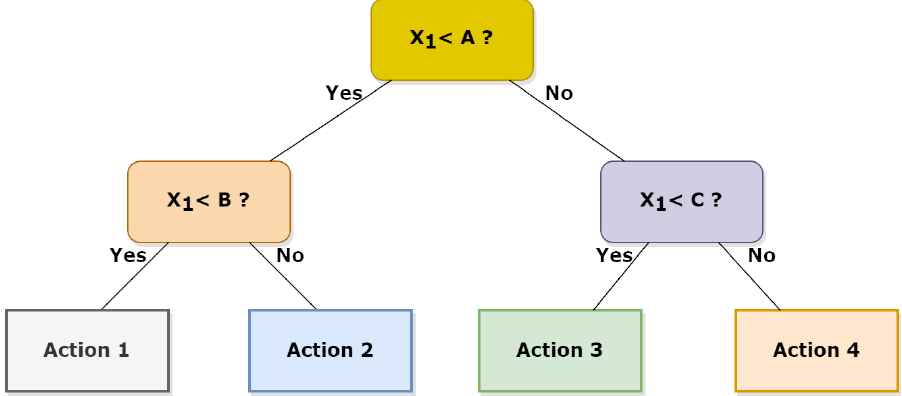
Figure 7. Example of decision tree with a different action corresponding to a different conditions